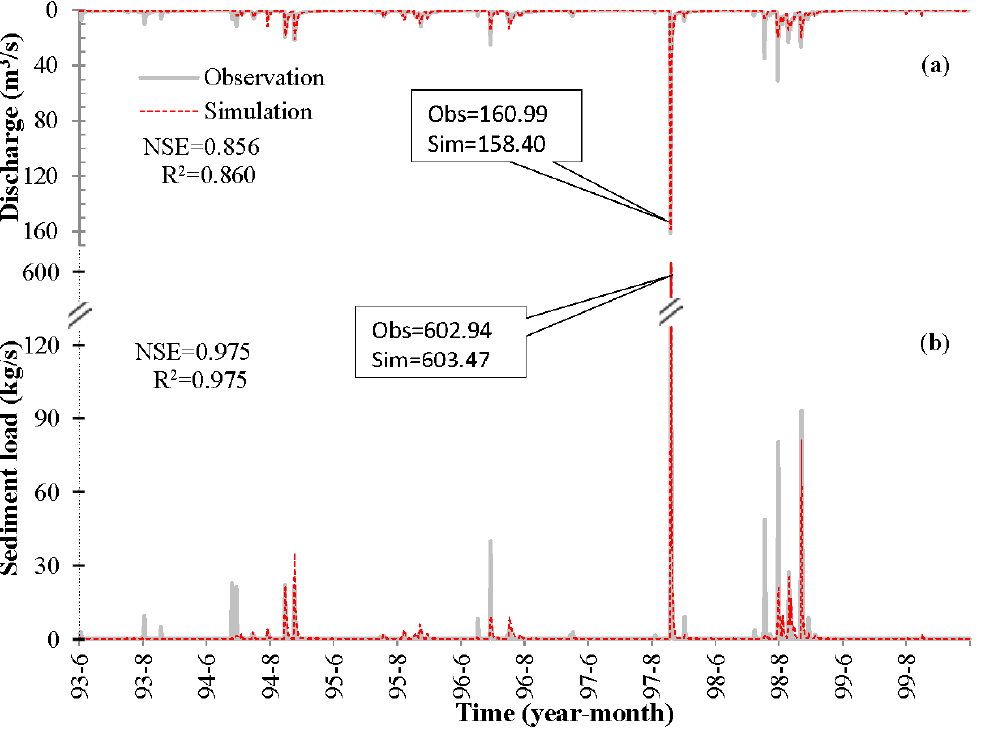
Table 3. Comparison of total flow and sediment amount between simulation and observation during flood season for each year.